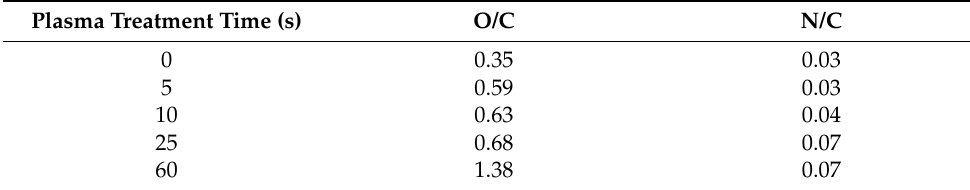
Figure 16. XPS full spectrum of CF/EP sample surface with different surface treatments. As can be seen from the results in Table 10, the contents of C, N and O on the surface of the untreated CF/EP samples are 69.48%, 1.75% and 23.15%, respectively, and the contents of N and O are lower. After sandblasting, the content of C, N and O did not change clearly, but the content of C on the surface of the sample decreased linearly compared with the original sample, the content of N increased in varying degrees and the content of O increased steadily with the increase in plasma treatment time. The content of Si element on the surface of the untreated CF/EP sample is 7.07%, which decreases slightly after plasma treatment, because the plasma treatment process is effective in removing silicon residues in the carbon fiber. When the time of plasma treatment was gradually extended from 5 s to 60 s, the content of C element on the surface of the sample decreased to 32.09%. The proportion of O element rose to 44.34%, indicating that the carbon pollutants on the surface of the composite could be removed through plasma treatment, and the oxygen in the air was ionized and adsorbed to the surface of the composite. When the plasma treatment time was 25 s, the content of N element was 3.7%, which is more than twice the content of N element in the untreated sample, but after extending the time of plasma treatment, the content of N element was reduced by 1.31%. This shows that low-temperature plasma treatment can quickly graft a large number of nitrogen-containing active groups onto the surface of the composites. These nitrogen-containing groups come from nitrogen in the air, but because the content of oxygen-containing groups in the plasma is higher and their activity is stronger, they will replace the active nitrogen-containing groups on the surface of the CF/EP after a longer treatment time. Table 11 summarizes the oxygen–carbon ratio and nitrogen–carbon ratio of the CF/EP samples before and after plasma treatment. Table 11. Oxygen–carbon ratio and nitrogen–carbon ratio of CF/EP sample surface with different plasma treatment times. Plasma Treatment Time (s) O/C